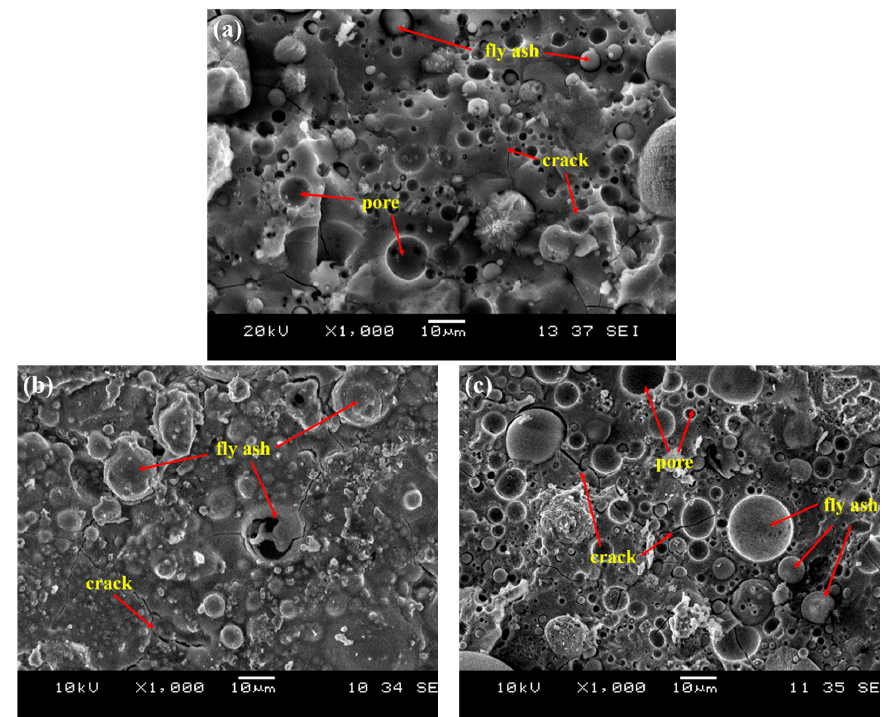
Figure 12. SEM micrographs of fly ash geopolymers with ( a ) 0%, ( b ) 2% and ( c ) 4% of silica fume. Magnetochemistry 2021 , 7 , x FOR PEER REVIEW